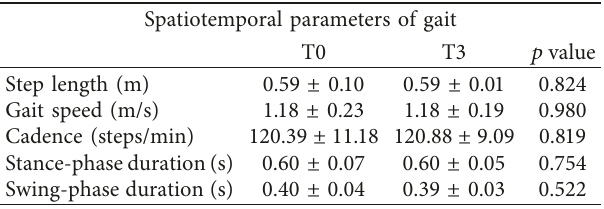
Values are expressed as mean ± SD. MVPA: moderate-to-vigorous physical activity; TS: time slot; a significant difference vs. TS 1; b significant difference vs. TS 2; ∗ sum of moderate and vigorous intensity; ∗∗ sum of light and moderate intensity. Table 3: Values of the spatiotemporal parameters of gait at the beginning and end of the 3-month observation period.